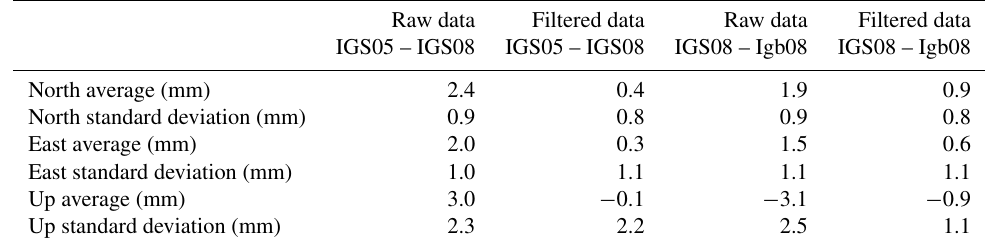
Table 1. Average offsets associated with the IGS reference frame transitions.